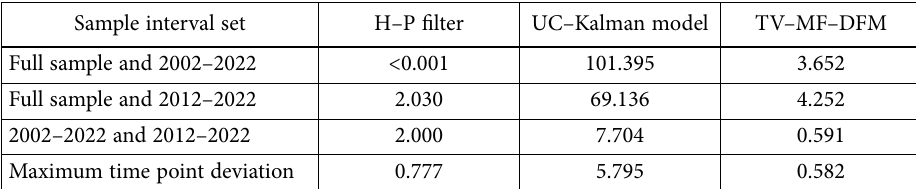
Table 5. Deviations of different models in different sample interval sets Sample interval